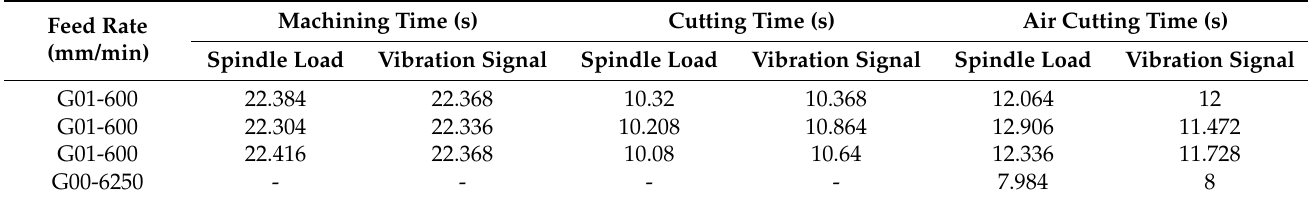
Table 6. Experiment results based on spindle load and vibration signal judgment.